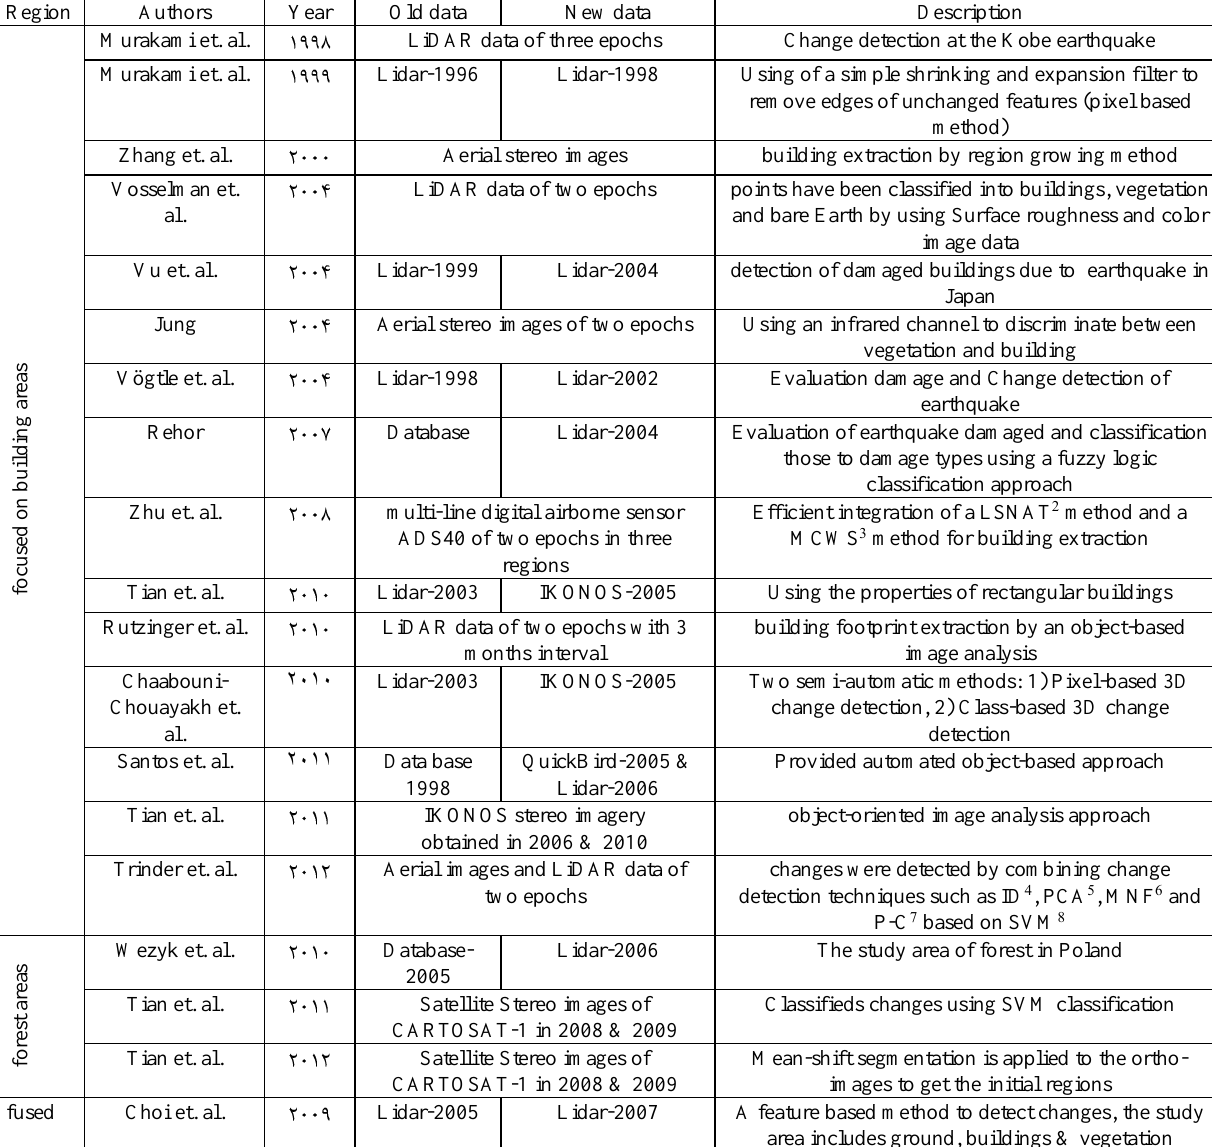
Table 1.Related work in DSM